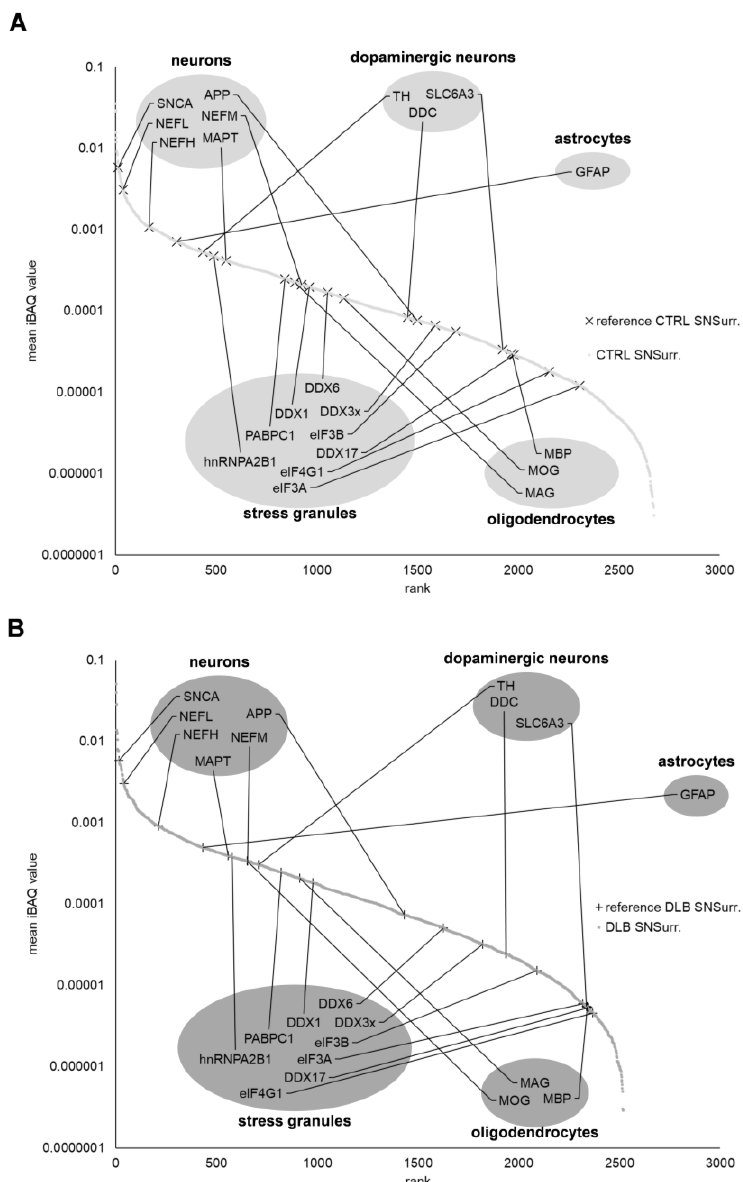
Figure 2. Ranking of protein expression intensities in SN Surr. tissue of both conditions. Plots display the normalized mean iBAQ-values of identified proteins in SN Surr. tissue of CTRL ( A ) and DLB ( B ) cases. General neuronal marker proteins as well as marker for stress granules, astrocytes and oligodendrocytes are comparable based on their ranks in CTRL and DLB SN Surr. tissue, while marker proteins for dopaminergic neurons rank lower in SN Surr. tissue of DLB cases. SNCA: α -synuclein, NEFL: neurofilament light chain, NEFM: neurofilament medium chain, NEFH: neurofilament heavy chain, APP: amyloid beta precursor protein, MAPT: microtubule associated protein tau, TH: tyrosine hydroxylase, DDC: aromatic-L-amino-acid decarboxylase, SLC6A3: solute carrier family 6 member